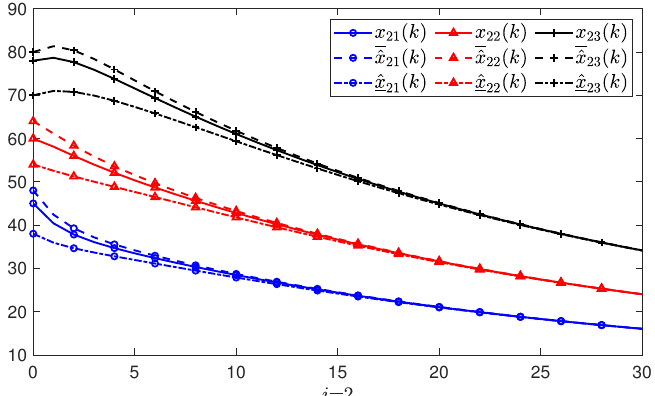
Figure 4. The simulations of all states and their estimations of the 2nd agent.